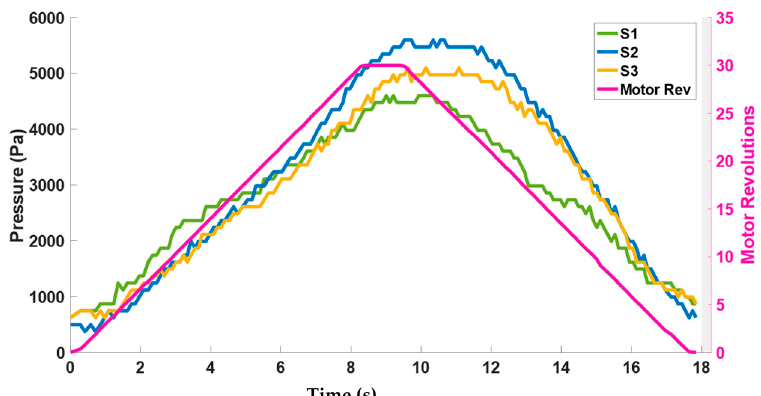
Figure 10. Contact force model validation results.